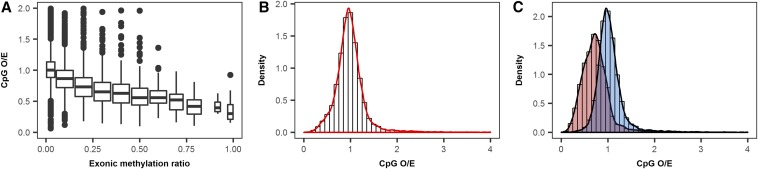
Patterns of methylation inferred from the CpG O/E (the observed to expected CpG ratio) statistic. (A) Correlation between the CpG O/E and experimentally deduced methylation ratio. (B) Unimodal distribution of CpG O/E. (C) Distribution of methylated (red) and nonmethylated (blue) genes (± 10% exon methylation ratio) per CpG O/E statistic.